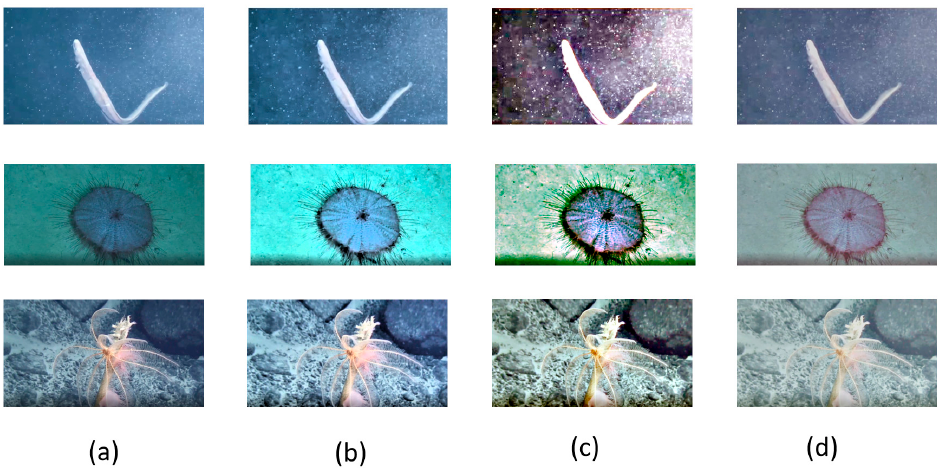
Figure 1. Image enhancement result map that relies on retinex theory based on ( a ) raw image, ( b ) MSR, ( c ) AMSRCR, and ( d ) MSRCR.